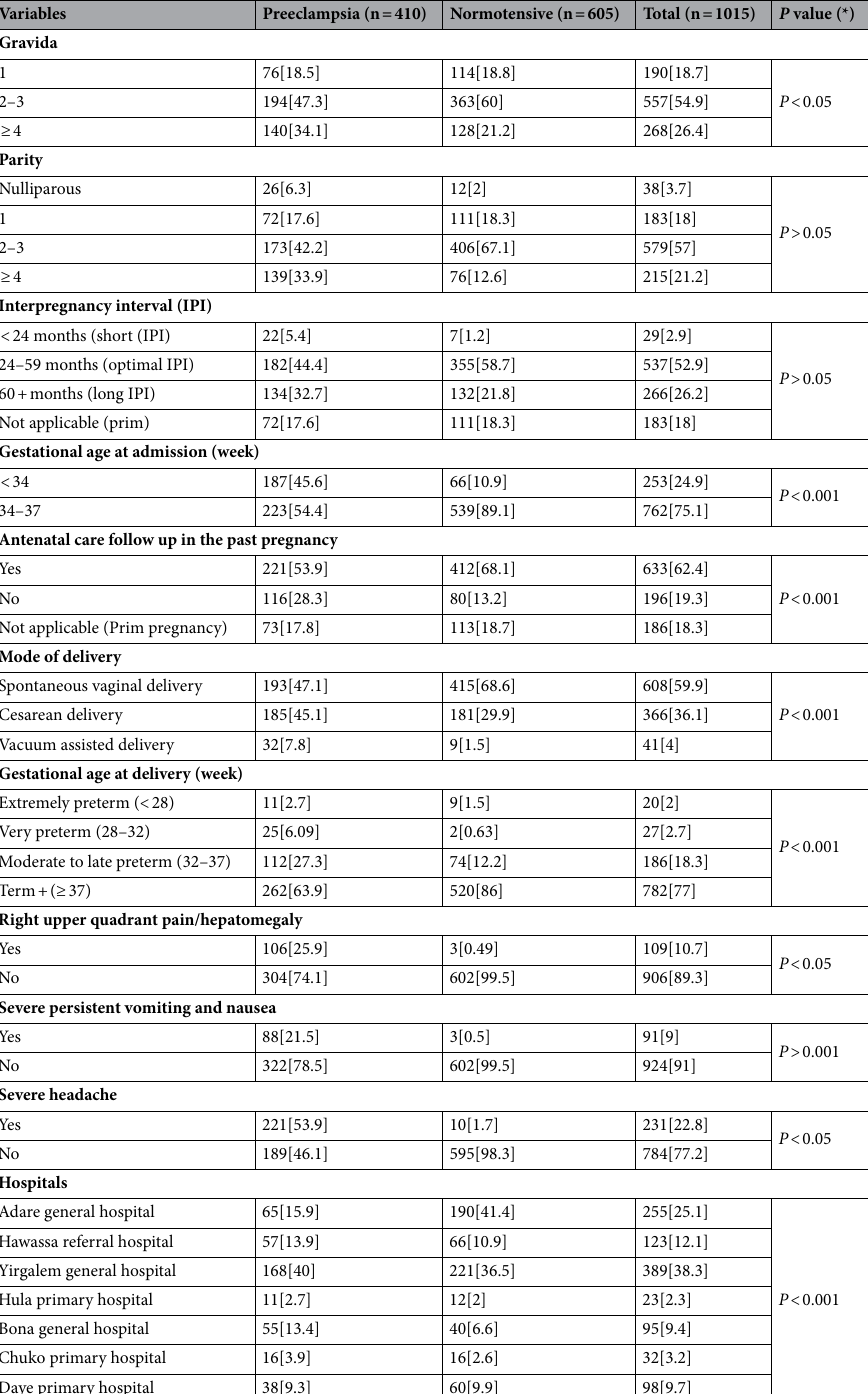
Table 2. Obstetrics characteristics of women with preeclampsia and normotensive women in Sidama region, southern Ethiopia from August 8, 2019, to October 1, 2020. * P value < 0.05 was considered statistically